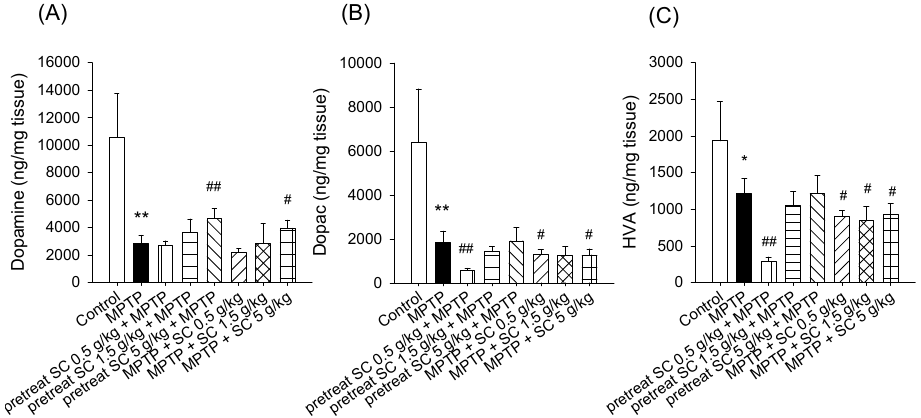
Figure 5. E ff ect of S. chinensis on the MPTP-induced loss of striatal dopamine ( A ) and its metabolites, ( B ) DOPAC and ( C ) HVA. The data are expressed as the mean ± S.D. ( n = 6). * p < 0.05 and ** p < 0.001 compared with the control group using a t test; # p < 0.05 and ## p < 0.001 compared with the MPTP group as determined by T -tests. MPTP, 1-methyl-4-phenyl-1,2,3,6-tetrahydropyridine; SC: Schisandra chinensis extract.